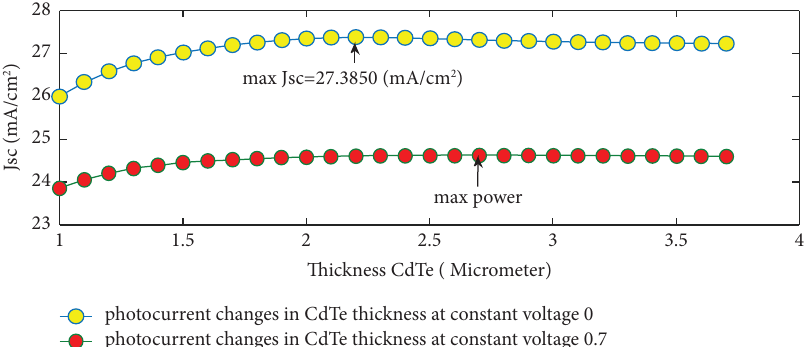
Figure 16: Short-circuit current according to the thickness of the absorber layer at two constant voltages of 0 and 0.7V.